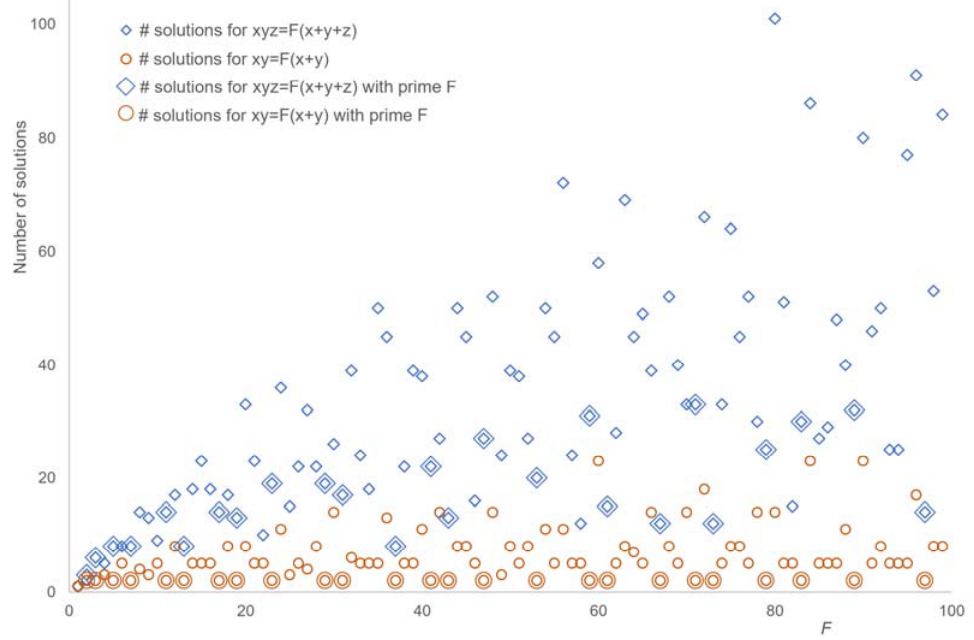
Figure 3. Enumeration of solutions of Diophantine equations xy = F ( x + y ) and xyz = F ( x + y + z ). All solutions for F < 100 have been counted. The number of solutions for prime F is marked by a larger circle ( n = 2) or diamond symbol ( n = 3).